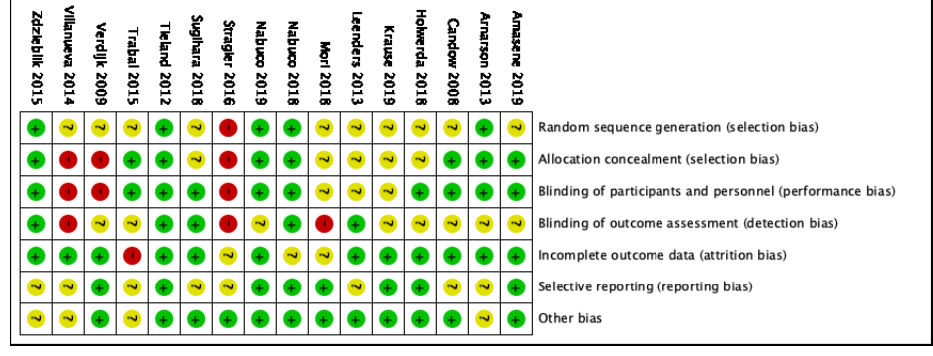
Figure 2. Risk of bias summary.